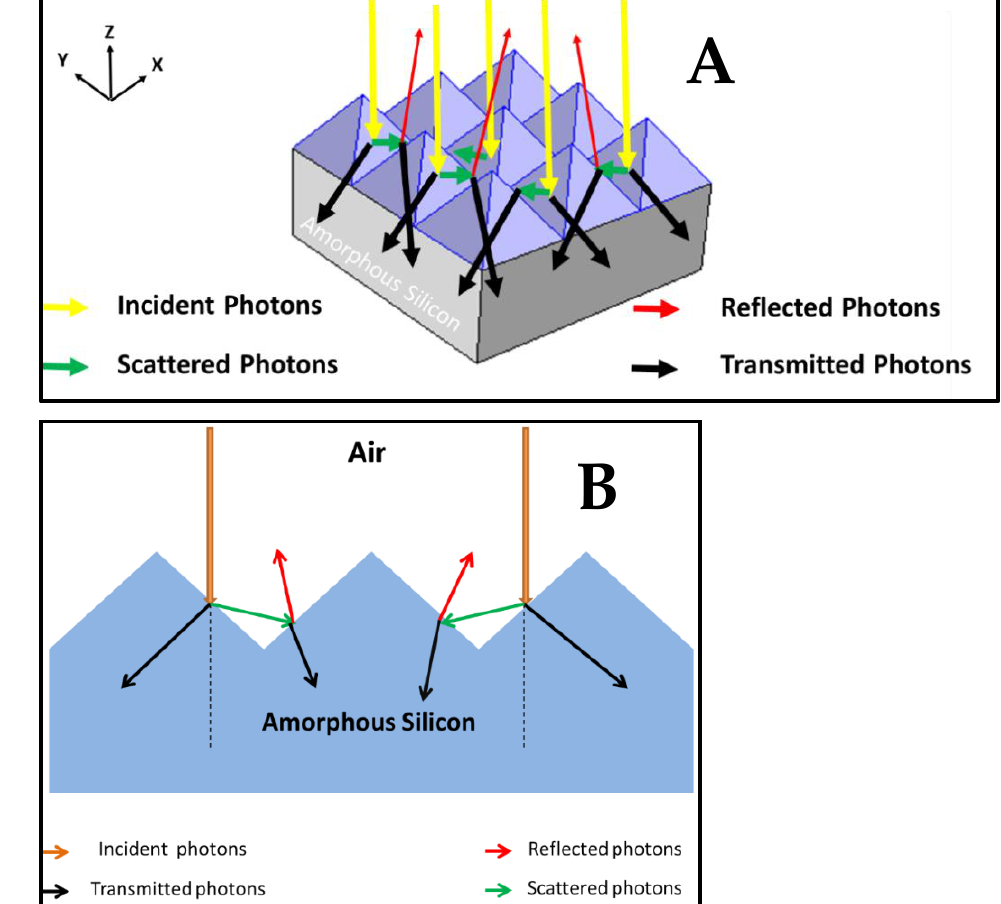
Figure 2. Schematic diagram of texturing surface with a path length of incident photons. ( A ) 3D structure, ( B ) side view.